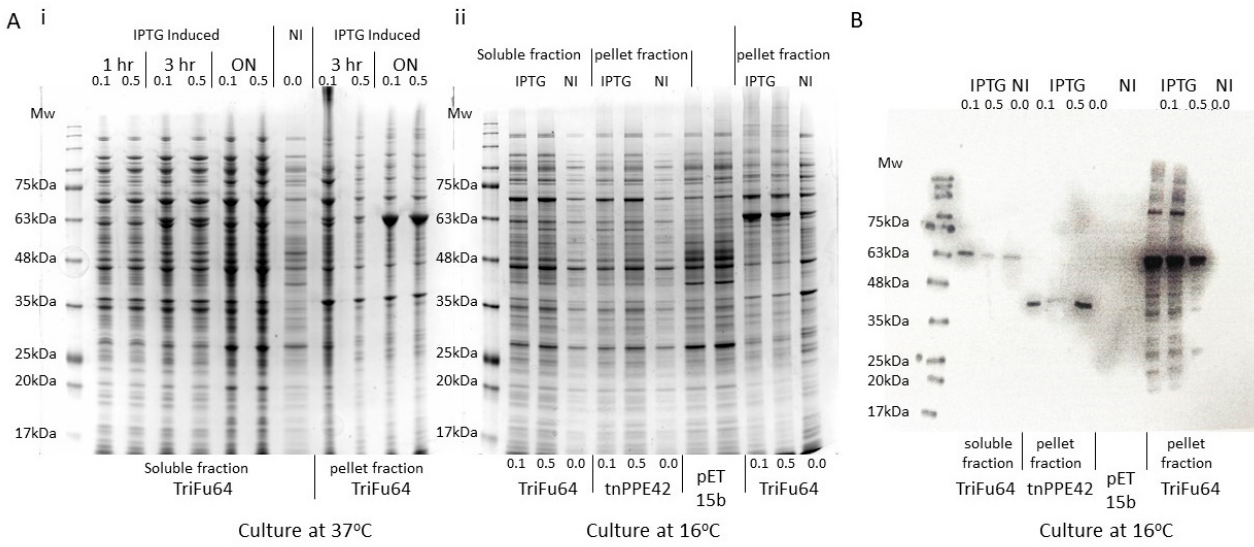
Figure 1. Determination of conditions required to generate tnPPE42 and TriFu64 triple-antigen fusion. Plasmids con- taining DNA fragments encoding the triple-antigen fusion genes were electroporated into E. coli , grown at 37 ◦ C ( A ( i )) or 16 ◦ C ( A ( ii ), B ) and induced with various concentrations of IPTG (0.0 (NI), 0.1 mM (0.1), or 0.5 mM (0.5)) for 1 h (1 hr), 3 h (3 hr) or overnight (ON). Both soluble and pellet fractions were generated, and the protein profile determined using 4–20% SDS-PAGE ( A ( i ), A ( ii )). ( B ) The presence of His-tagged proteins of the correct size in the soluble (sol. frac.) or pellet (pel. frac.) fraction was determined by Western blot analysis using an anti-poly histidine antibody.